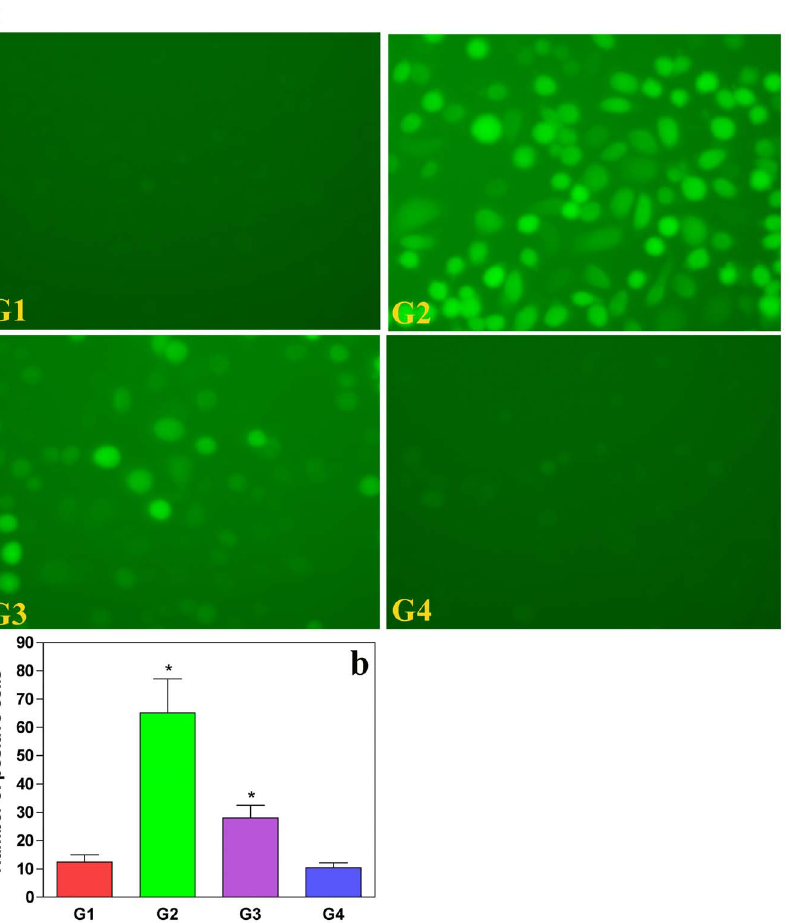
Figure 2. C-phycocyanin quenches oxalate-induced ROS production in MDCK cells. ( A ) MDCK cells treated with oxalate were observed for ROS generation with a non-fluorescent dye DCFDA, which converts to a fluorescent DCF compound during oxidative stress (panel G2). This is compared with panel G1 (normal conditions). Panel G3 shows reduced fluorescence due to reduced generation of ROS upon CP pre-treatment, which resembles normal cells. Panel G4 confirms that CP alone by itself is not cytotoxic. ( B ) Quantitative estimation of DCF fluorescence, oxalate-induced MDCK cells (G2) shows exaggerated fluorescence as compared to control, and reduced florescence was observed in the CP pre-treated cells (G3). Values are expressed as mean 6 S.D. P , 0.05 were considered significant. *G2 compared with G1; G3 compared with G2. G1: Control; G2: Oxalate; G3: Oxalate + CP; G4: CP alone.